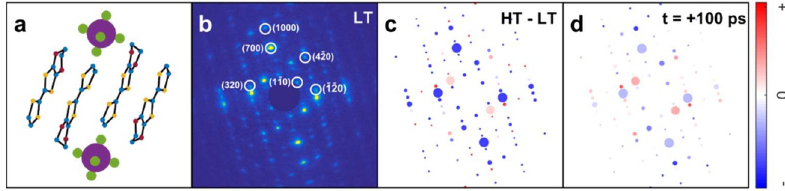
Fig. 1 . (a) Crystal structure of (EDO-TTF) 2 SbF 6 . (b) Electron diffraction pattern of the LT phase. Integrated change in intensity between the ground LT state and (c) the HT state, and the photoexcited state after 100 ps